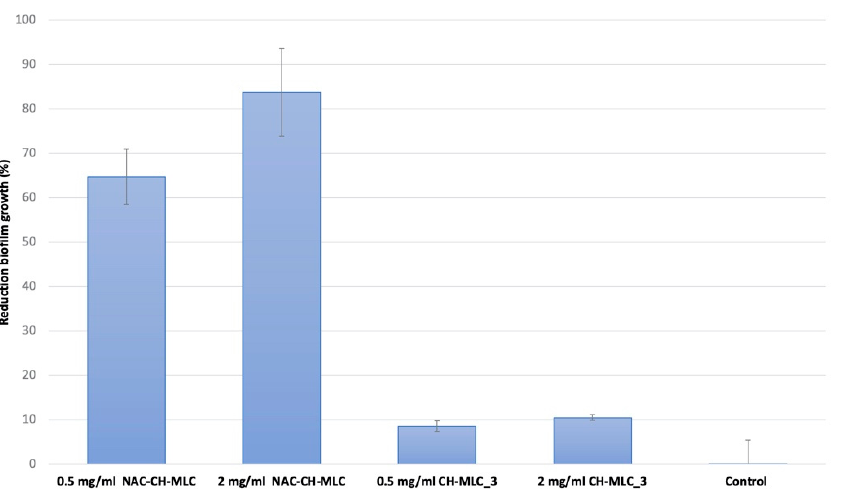
Figure 9. Efficacy of MLC in bacterial cell reduction. Sample concentrations are expressed as percentage of active concentration of 0.5 mg/mL of NAC-CH-MLC, 2 mg/mL of NAC-CH-MLC, 0.5 mg/mL of CH-MLC_3, and 2 mg/mL of CH-MLC_3.